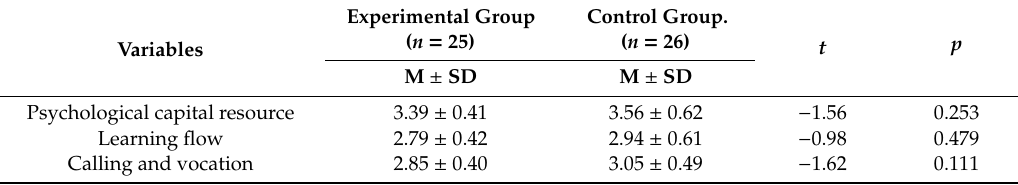
Table 3. Homogeneity test of outcome